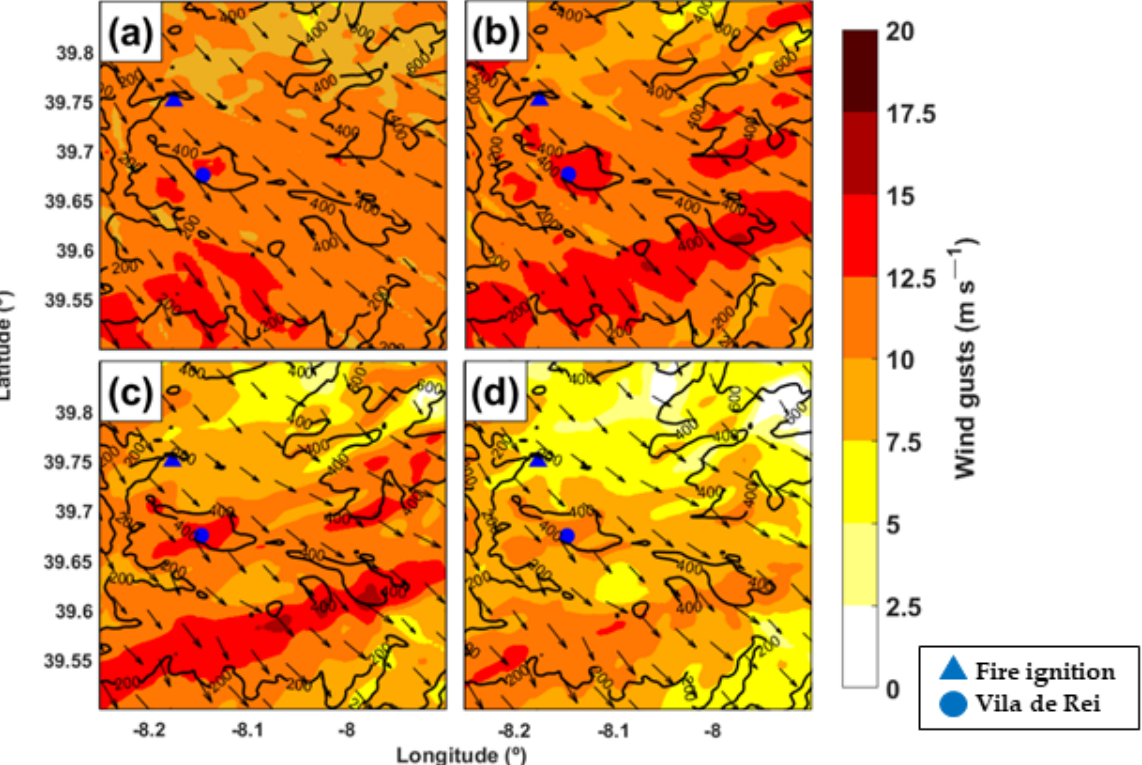
Figure 8. Wind gusts (coloured), wind direction (arrows), and orography (contour) of the local burned area by 500 m resolution on 20 July 2019 ( a ) at 1500 UTC, ( b ) 1800 UTC, ( c ) 2100 UTC, and ( d ) 0000 UTC on 21 July 2019.